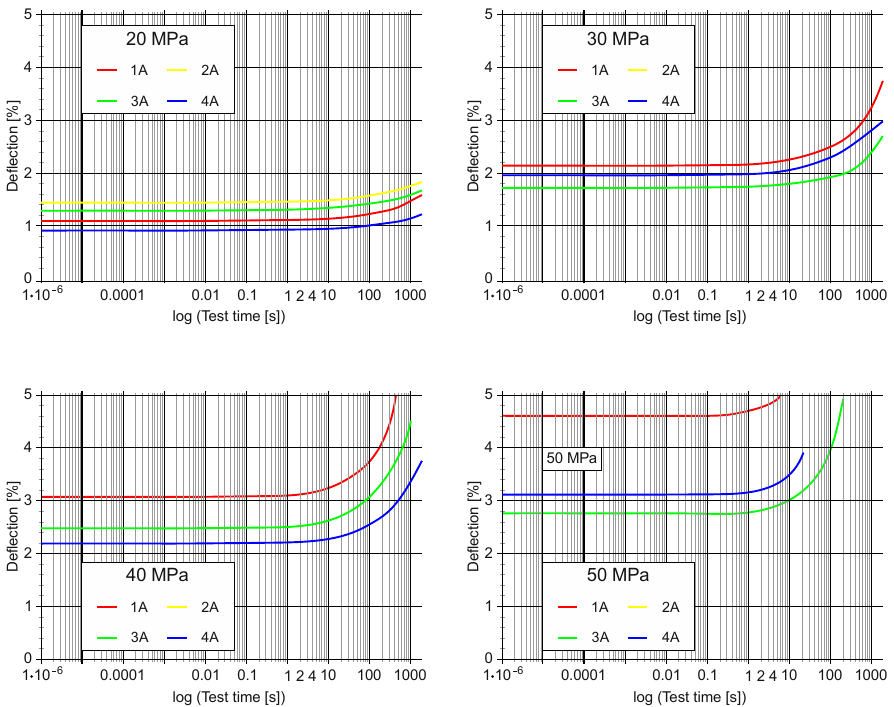
Figure 9. The course of deformation changes over time (logarithmic) during creep. Table 7. Creep test results.